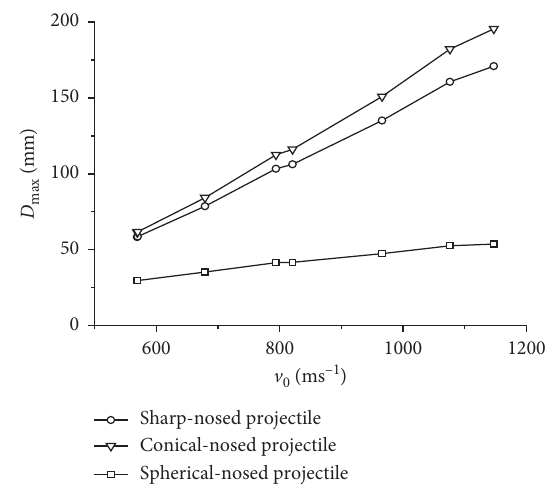
Figure 8: Comparison of penetration depth with different pro- jectile nose